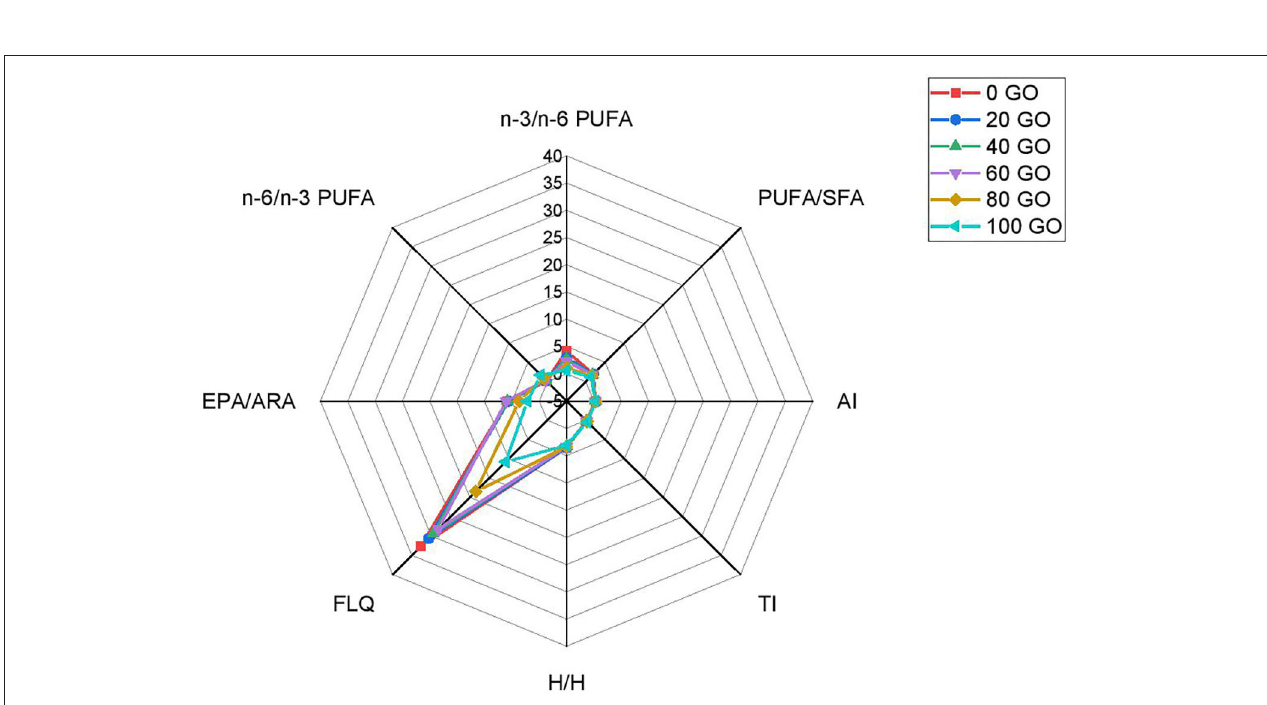
FIGURE 2 | Radar plot of the indices of nutrition quality of filet fatty acids of rohu fingerling fed on different experimental diets. Values are the mean of triplicate groups of fish.